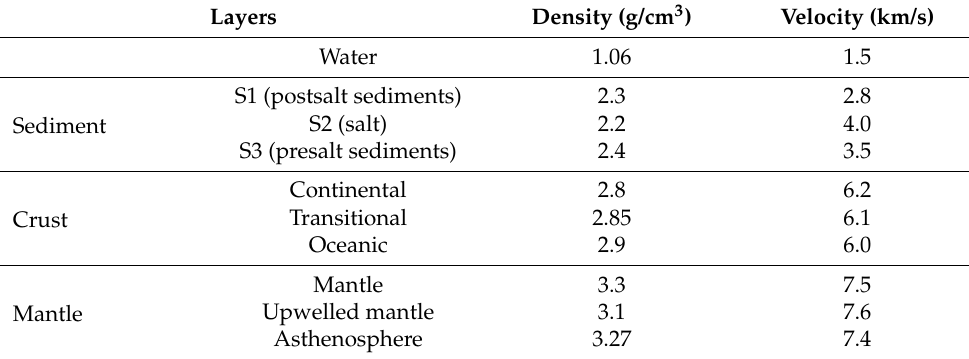
Table 2. Structural layers and parameters in the gravity model.